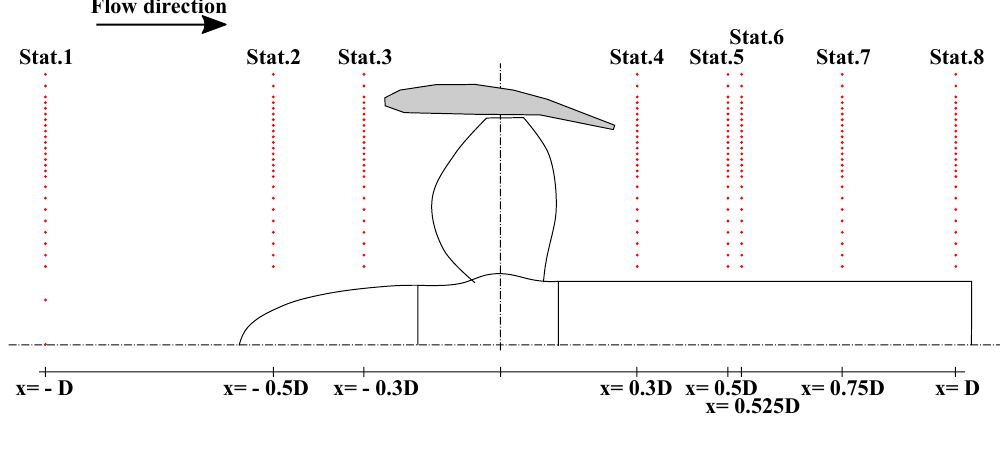
Figure 2. Experimental measurement section